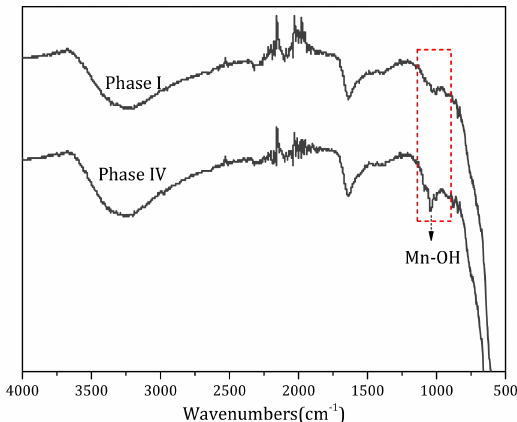
Figure 10. Fourier transform spectroscopy (FTIR) spectra of the Fe–Mn co-oxide during phases I and